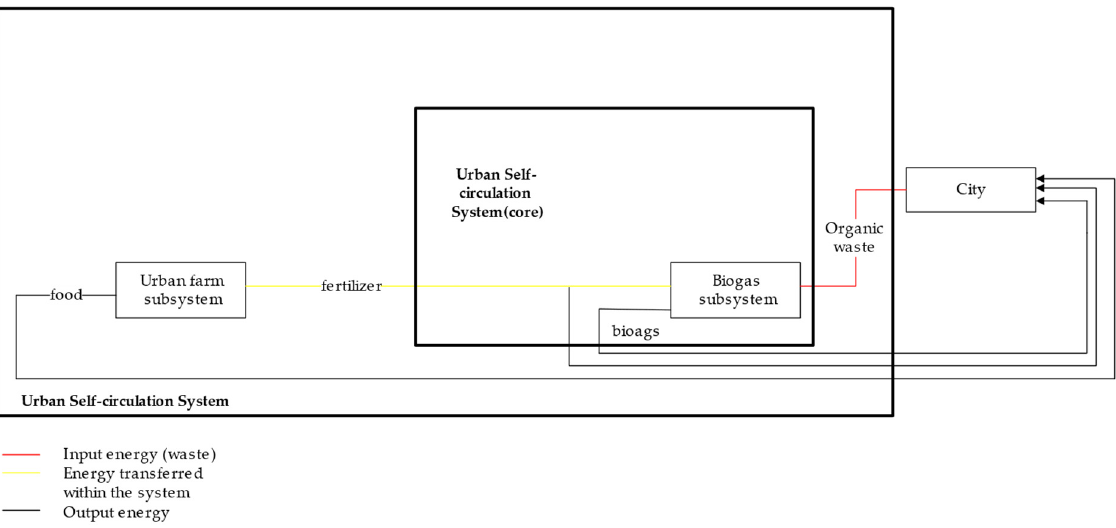
Figure 2. Flows of Organic Waste and Derivatives.